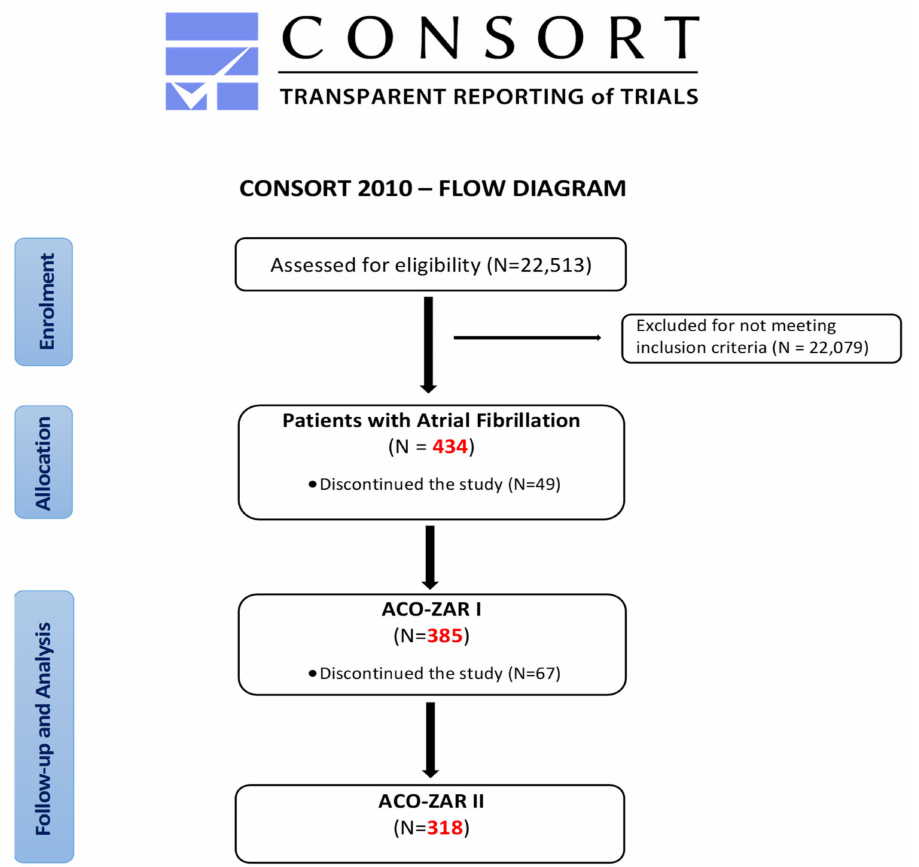
Figure 1. Consort Flow